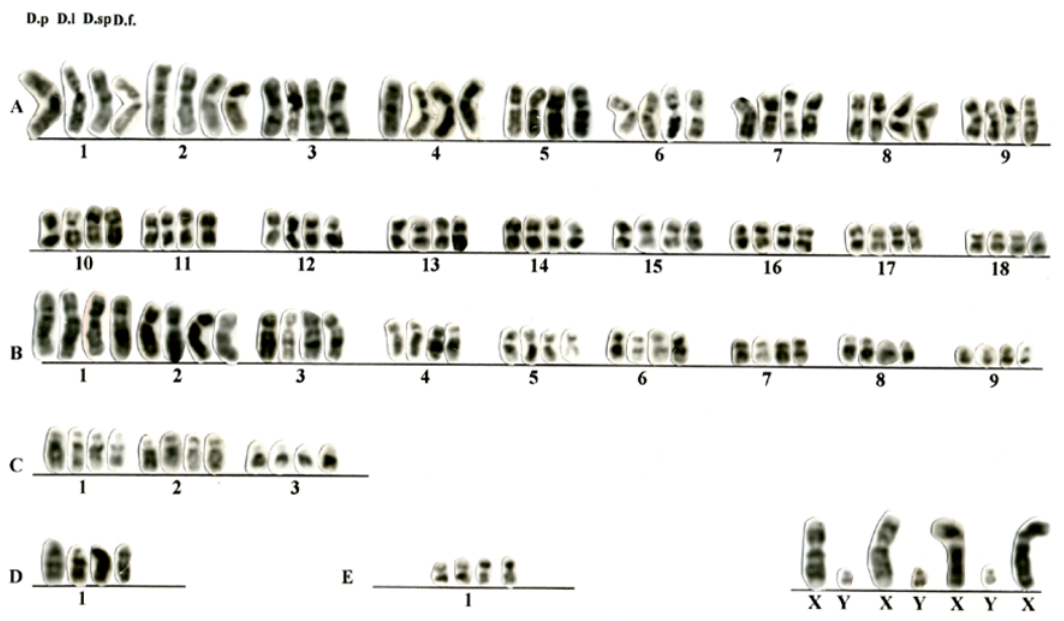
Fig. 8 – Comparisons of the banding standard G (GTG) in the four analized species. D.p – D. prymnolopha ; D.l – D. leporina ; D.sp – Dasyprocta sp.; D.f – D. fuliginosa